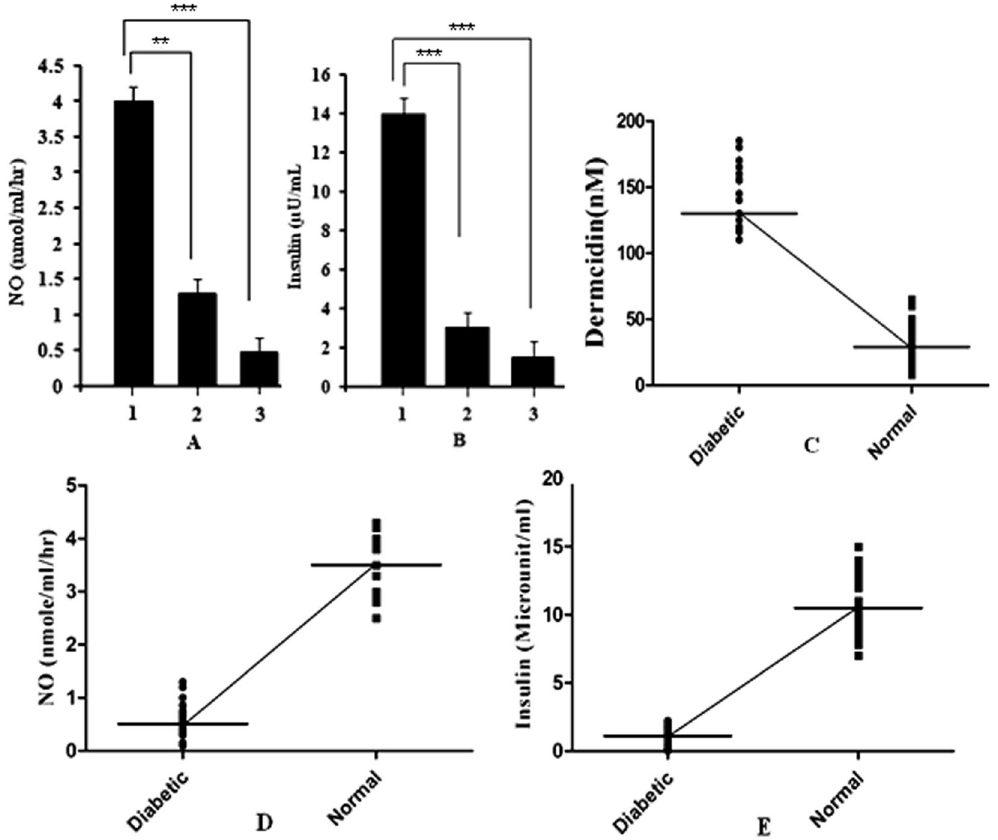
Figure 2. Plasma level of NO and insulin in normal and T1DM volunteers and their correlation with plasma dermcidin level: NO and insulin levels were measured by methemoglobin method and by ELISA in each volunteers as described in Materials and Methods. Panel-A: ‘1’ represents the plasma NO level in normal volunteers. ‘2’ and ‘3’ represents the plasma NO level in T1DM volunteers. Panel-B: ‘1’ represents the plasma insulin level in normal volunteers. ‘2’ and ‘3’ represents the plasma insulin level in T1DM volunteers. Panel-C, D and E represents highly and negatively correlation between plasma dermcidin and plasma NO and insulin level in T1DM and normal subjects. Each point represents the amount of insulin ( µ U/mL), NO production (nmol/ mL/hr) and dermcidin level (nM) of at least 30 age and sex matched normal volunteers with T1DM volunteers (n = 30, male = 15, female = 15). ( *** Represents p < 0.0001, ** represents p <